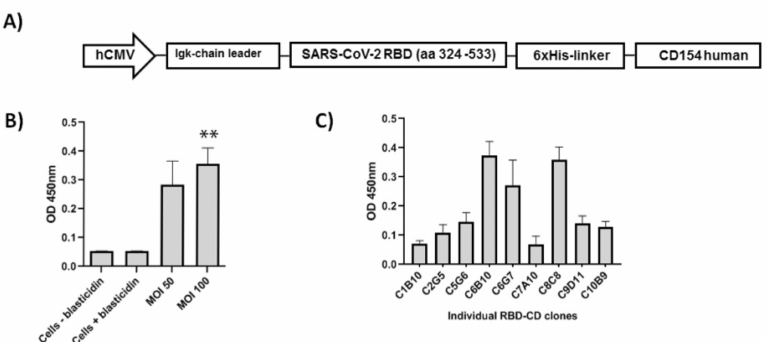
Figure 1. Construction and expression of RBD-CD in HEK-293 cells. ( A ) Schematic representation of the construction encoding the protein RBD-CD. The diagram indicates in that order from the N - towards the C -terminal end: a fragment of the human cytomegalovirus enhancer/promoter (hCMV), the Igk-chain leader sequence, a segment of RBD, a six-histidine tail plus a linker, and the extracellular domain of human CD154. ( B ) Protein expression in cell pools obtained after lentiviral transduction and selection with blasticidin determined by ACE2 binding in ELISA. Data are represented as mean + STD of six replicates. A Kruskal–Wallis and Dunn’s multiple comparison test were performed. Asterisks represent statistical differences with controls. (** p < 0.01) ( C ) ELISA to compare individual clones obtained by limiting dilution. Data are represented as mean + STD of three replicates.